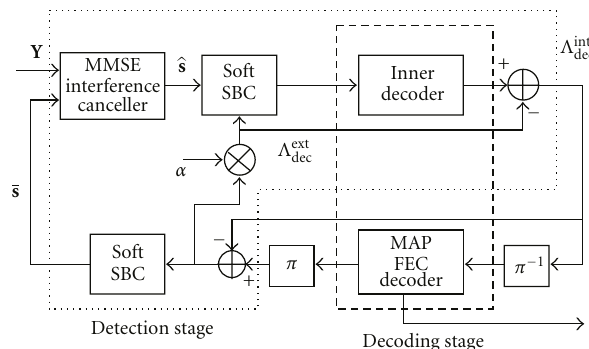
Figure 3: Proposed turbo receiver scheme for concatenated STECCs.